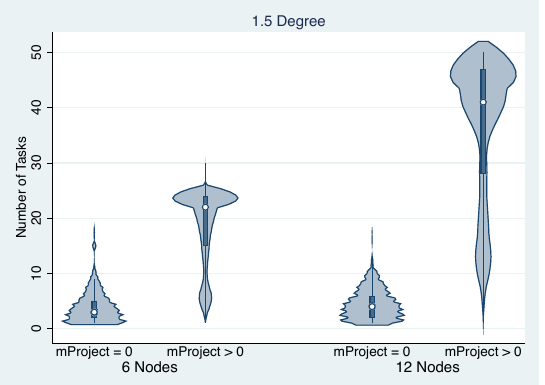
Figure 13. Total number of executing jobs when mProject jobs are running ( right ) vs. no mProject jobs running ( left )—comparison 6 nodes vs. 12